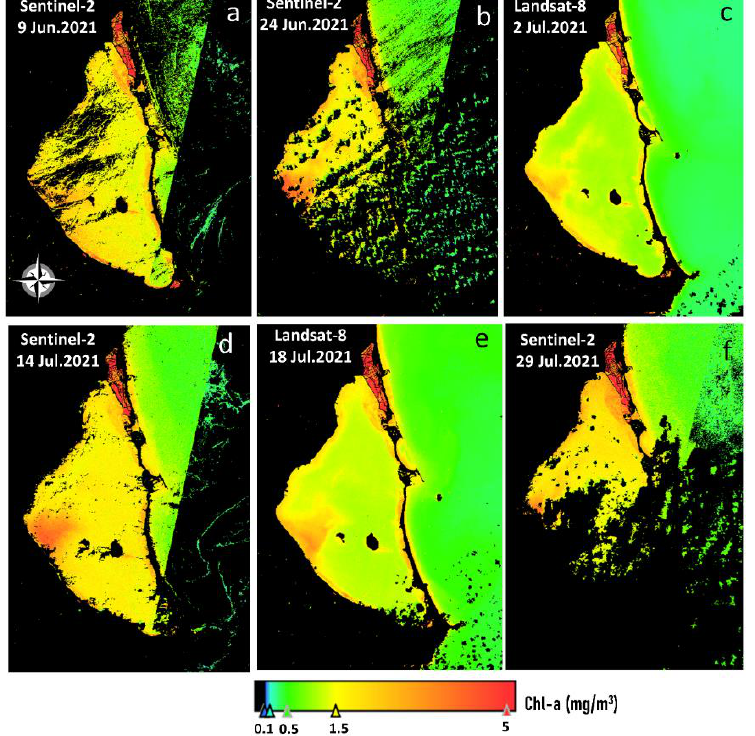
Figure 11. Chlorophyll-a concentration (Chl-a, mg/m 3 ) from Sentinel-2 and Landsat-8 acquired on